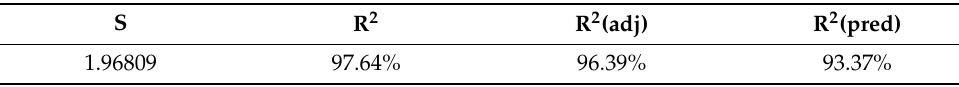
Table 1. Model summary of GA conversion.